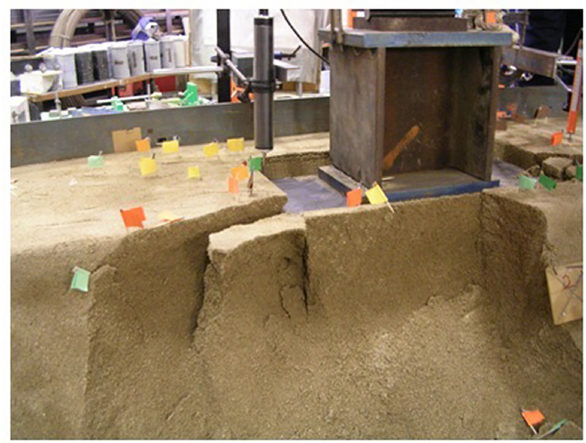
Figure 9. Slope failure beneath bearing